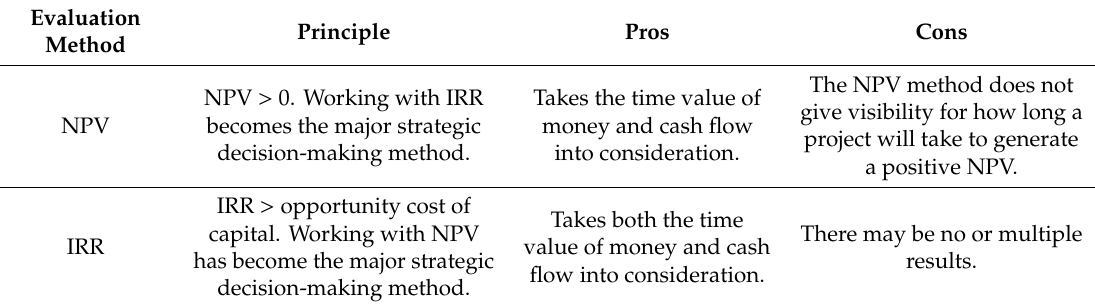
Table 1. Discounted Cash Flow Evaluation Methods: The pros and